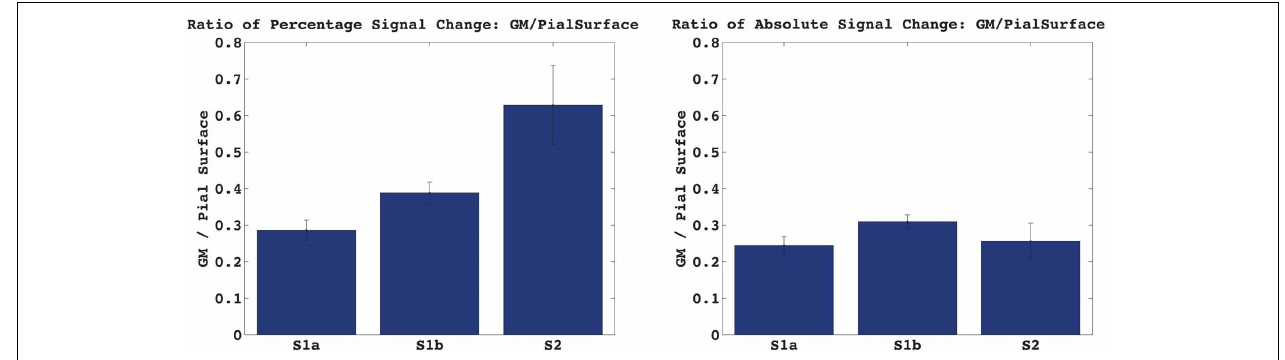
FIGURE 4 | Activation induced signal change in GM vs. at the Pial surface. The ratio of the absolute signal change in the cortex vs. at the pial surface is very similar for S1 and S2, contrary to what is expected from a T2-weighted vs. a T2 ∗ -weighted